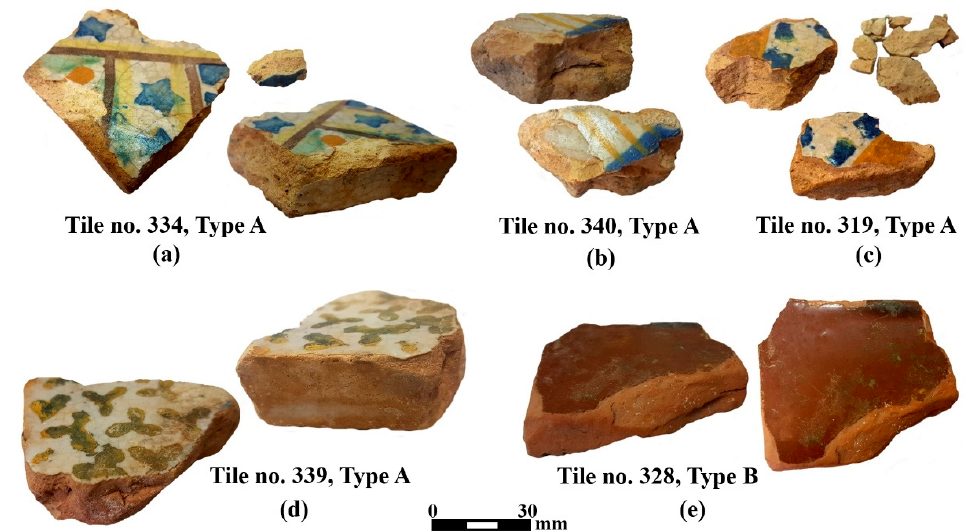
Figure 2. Tile fragments. Type A: ( a ) tile no. 334; ( b ) tile no. 340; ( c ) tile no. 319; ( d ) tile no. 339; and Type B: ( e ) tile no. 328 (photos: D. Ashkenazi).